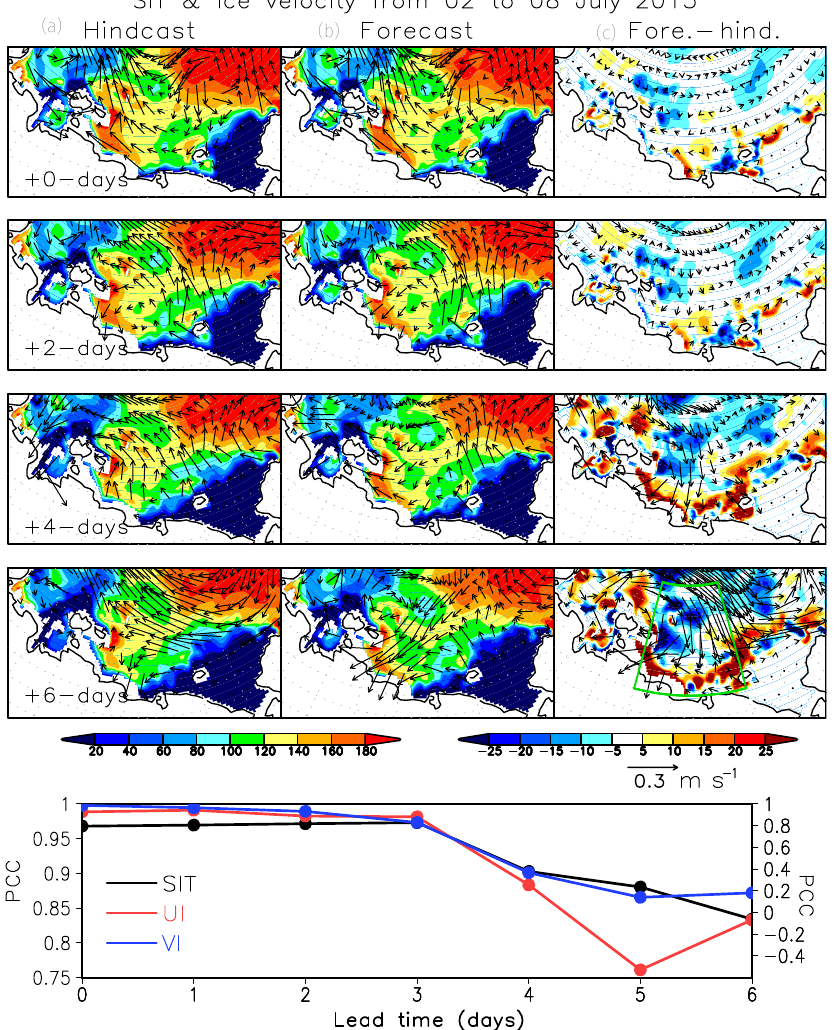
Figure 8. Temporal evolution of SIT (centimetres; colours) and ice velocity (ms − 1 ; vectors) distribution for the (a) analysis, (b) forecast and (c) the difference between the forecast and analysis at increasing lead times from + 0 days to + 6 days initialized on 2 July 2015. The corresponding PCCs for the SIT (black), zonal (red) and meridional ice speeds (blue) in the ESS (right-lower panel of the time evolution) are shown in the lower panel. The scale for the PCCs of the zonal and meridional ice speeds is indicated on the right